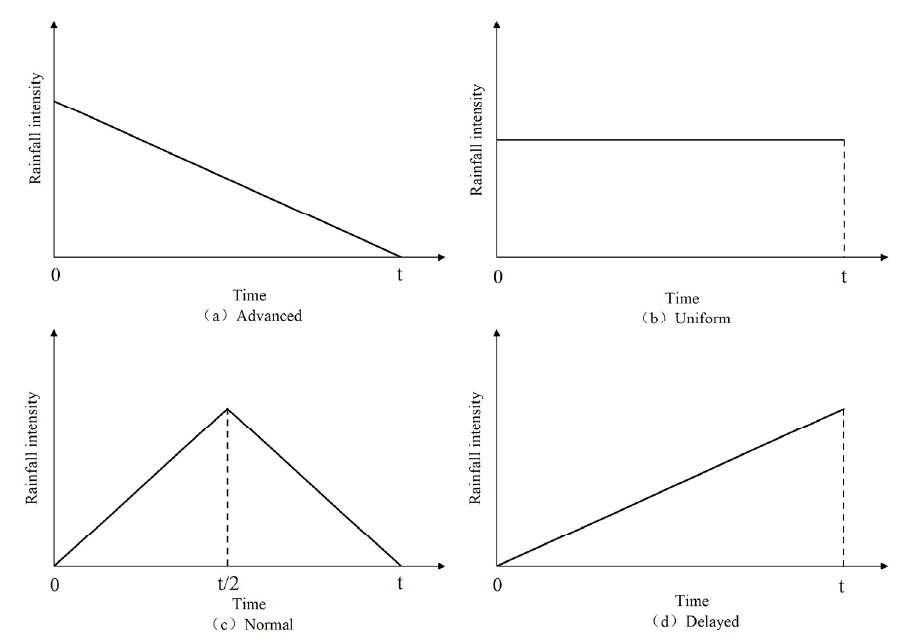
Figure 6. Typical rainfall patterns employed in this study.